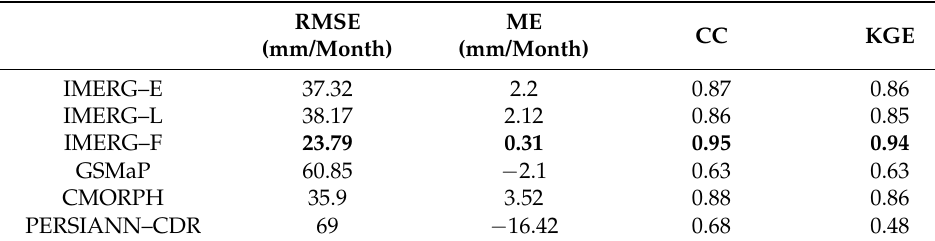
Table 4. Monthly precipitation statistics of the six satellite precipitation products over mainland China from 2001 to 2015 *.